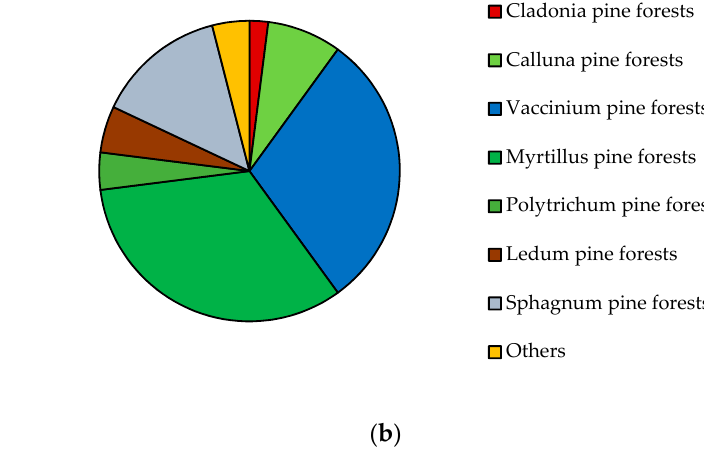
Figure 1. ( a ) Study area location (red dot). The main areal of Pinus sylvestris L. is highlighted in green. ( b ) Pine forests distribution area by the main types in the middle taiga zone of the Karelia Republic are presented [25,26].